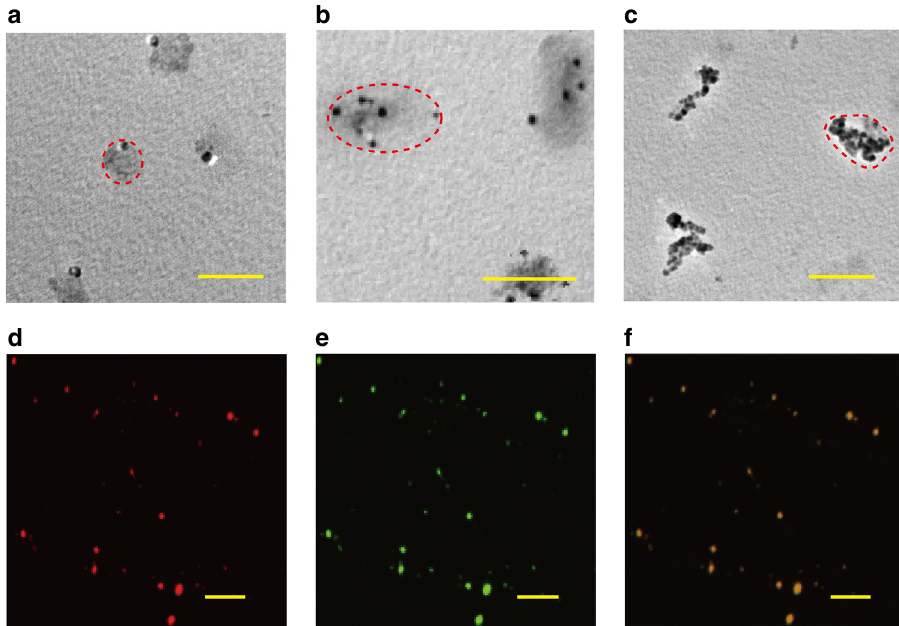
Fig. 4 Multifunctional particles/composites. TEM images show the production of particle composites by incorporating metals or oxides during the fabrication (sublimation/deposition) process. a An average 50.3 ± 4.2 nm particle composite was obtained by incorporating 12 nm gold particles in the composite, scale bars: 100 nm; b the incorporation of a number of 6 and 20 nm silver particles resulted in a 189.0 ± 15.3 nm particle composite, scale bars: 200 nm; and c a number of approximately 18 and 15 nm Fe 3 O 4 particles were incorporated and resulted in a 385.7 ± 20.6 nm particle composite, scale bars: 500 nm. Dotted lines were drawn to indicate the contour of the polychloro- para -xylylene polymer. The CLSM images show the multifunctional poly- para - xylylene copolymer that was used for the incorporation of the Fe 3 O 4 nanoparticles, and the reactivity of the installed NHS-ester and ester-alkyne groups was con fi rmed using d Alexa Fluor ® 555 azide in the red channel (scale bars: 10 μ m) and e FITC-labeled BSA in the green channel (scale bars: 10 μ m). An overlaid image of the red and green channels in f indicated the multifunctional presentation and paralleled immobilization of the two fl uorescent molecules on the same particle composites (scale bars: 10 μ